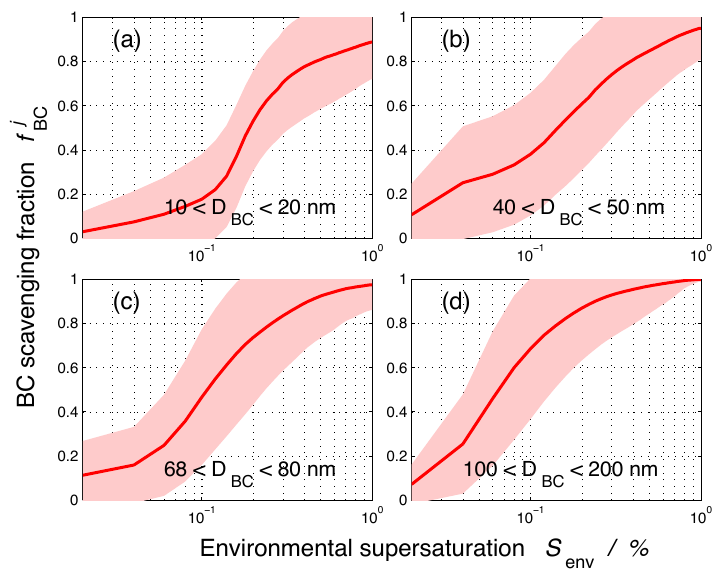
Figure 4. The nucleation-scavenged BC mass fraction, f j supersaturation. The solid line represents the average over the 384 populations, and the color shading indicates one standard deviation.